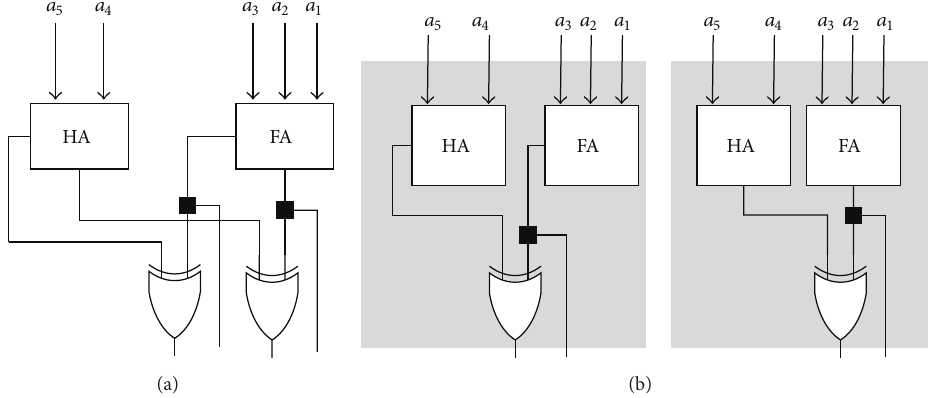
Figure 8: Covering for (0, 6; 3) GPC. (a) Combined network. (b) Restructuring for optimal covering.